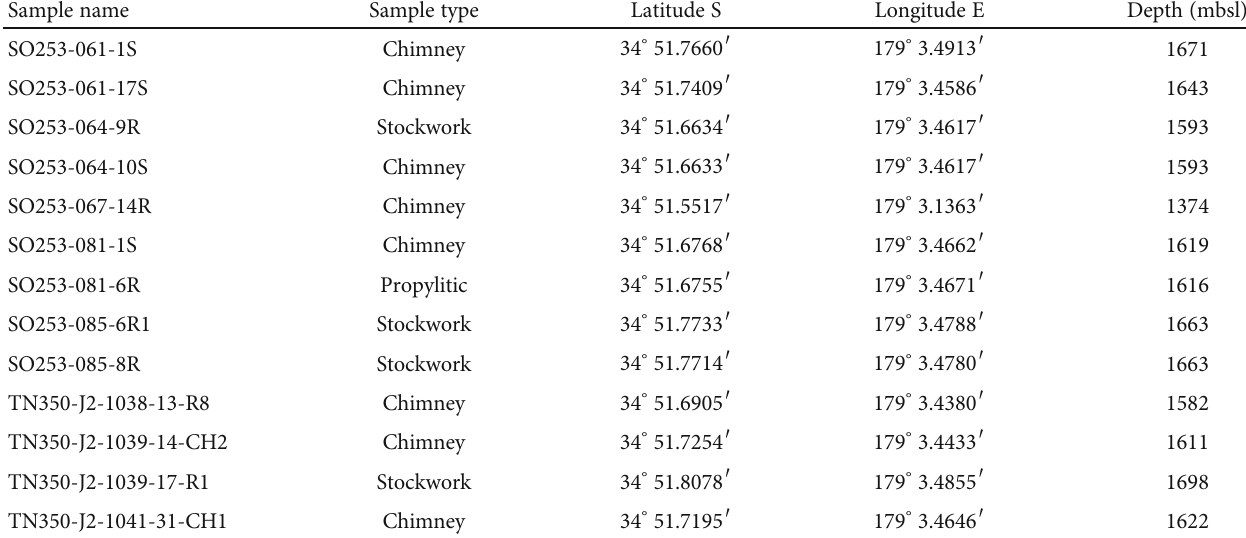
Table 1: Sample type, location, and water depth for samples of this